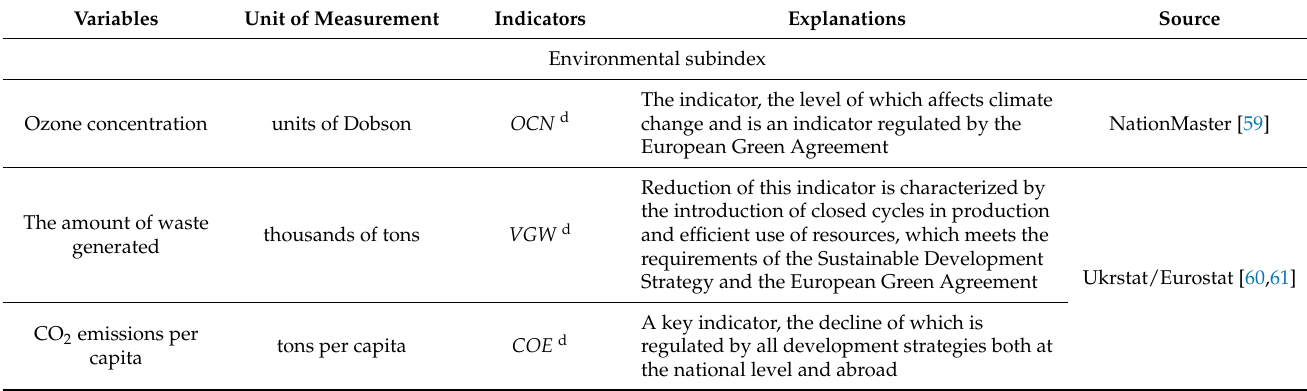
Table 1. Description of the source data for calculation integrated index of energy